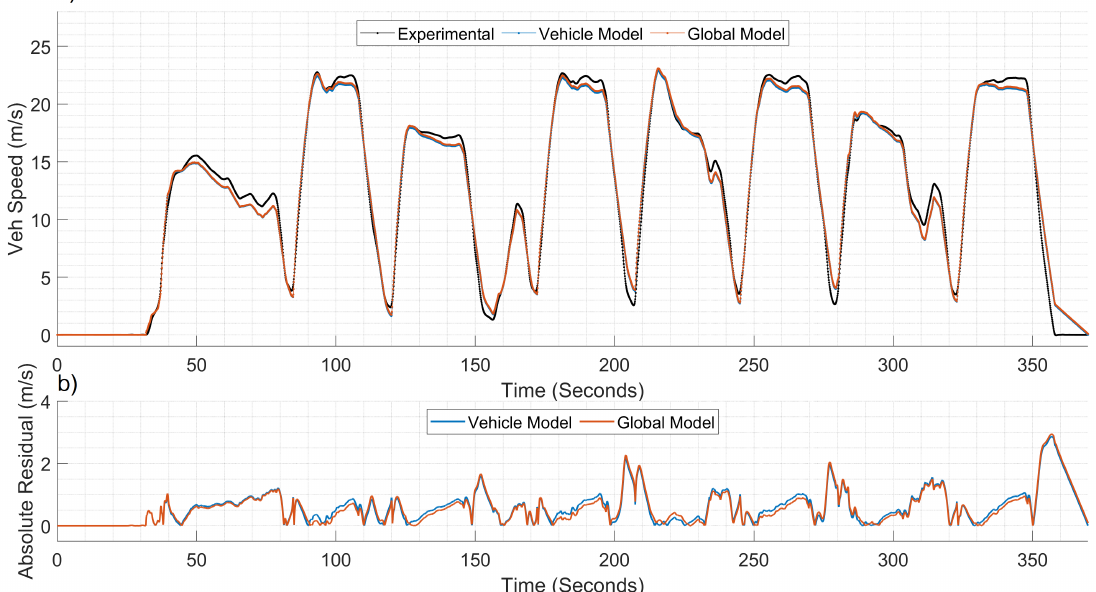
Figure 20. Test #6.4. Two-wheeler performance prediction: ( a ) the vehicle speed (m/s) of the global model compared to that of the single vehicle model and experimental data, ( b ) absolute residual error of global and vehicle